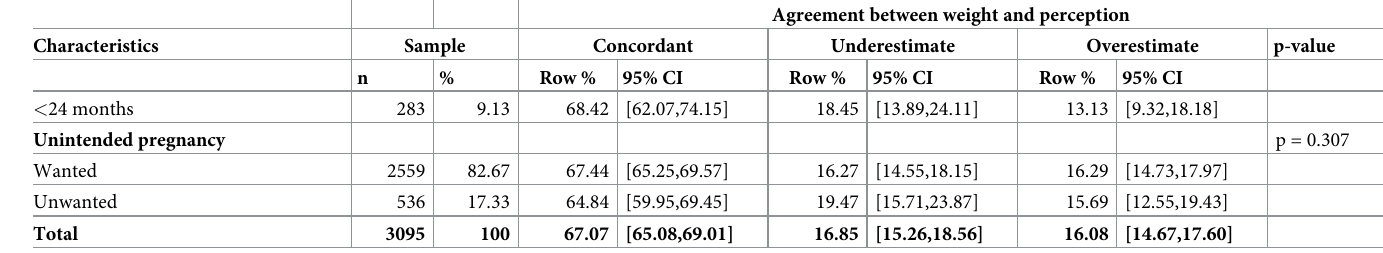
categories of normalized birth weight). Kappa statistics with a 95% confidence interval